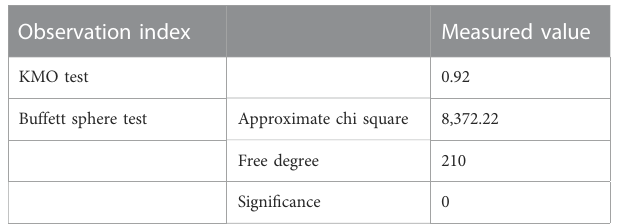
TABLE 7 KMO and buffett sphere test.